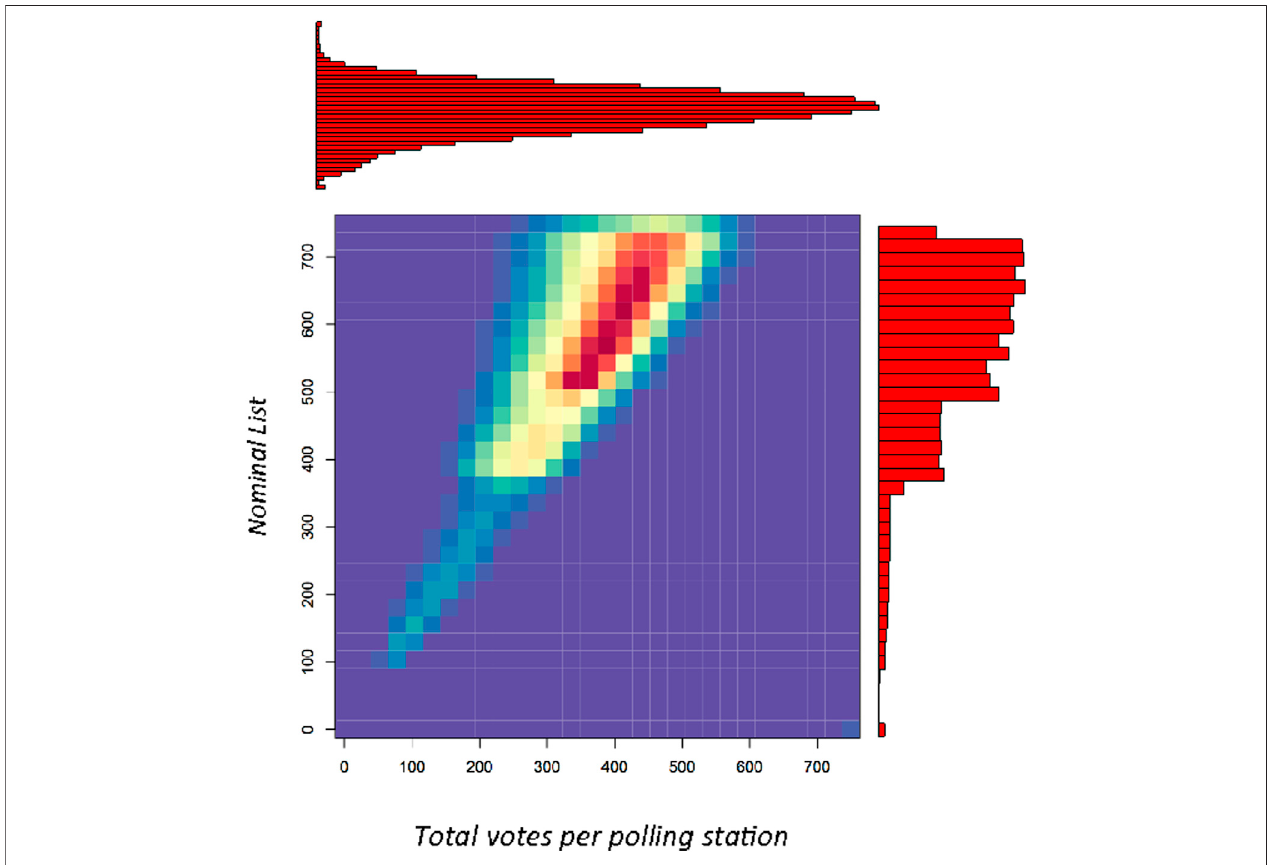
FIGURE6| HeatmapofthetotalnumberofvotesperpollingstationandNominalListforthe2018presidentialelection:thecolorcodestartsinblueforzerovalues and ends in red for increasing values. In the upper part, distribution of total votes which appears in Figure 3C as black line is presented. At the right, the Nominal List histogram is given, a detailed view appears in Figure 2